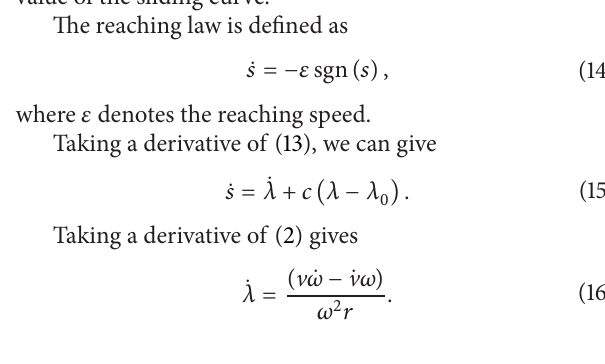
Figure 12: Optimization results right front